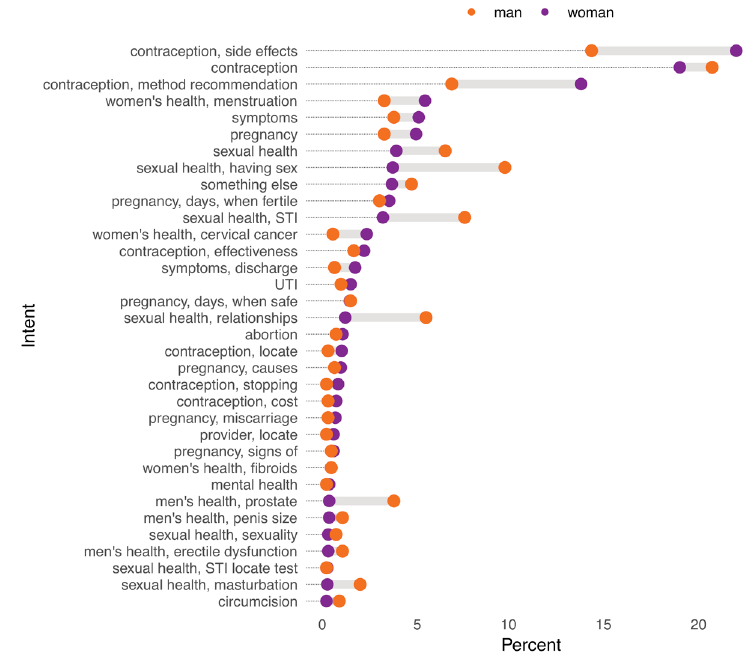
Figure 10. Distribution of classified intents by gender. STI, sexually transmitted infection; UTI, urinary tract infection.